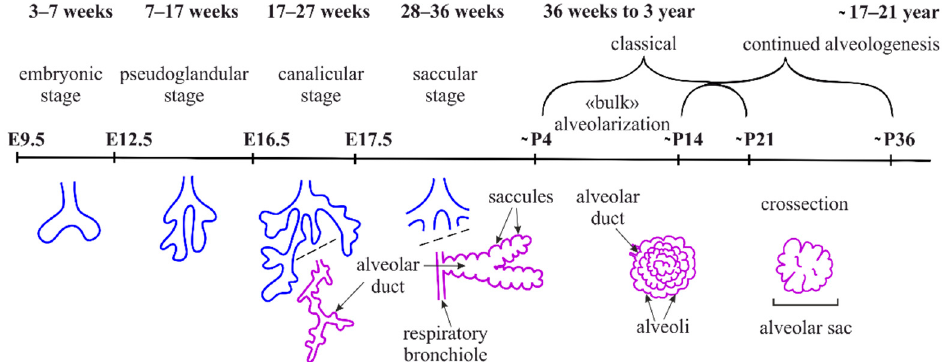
Figure 1. Lung development. Development of the lung as a whole and its proximal parts is shown in blue. Development of the distal lung and alveologenesis is shown in purple. E, embryonic day; P, postnatal day. The timescale, shown in weeks, refers to the stages of human lung development.